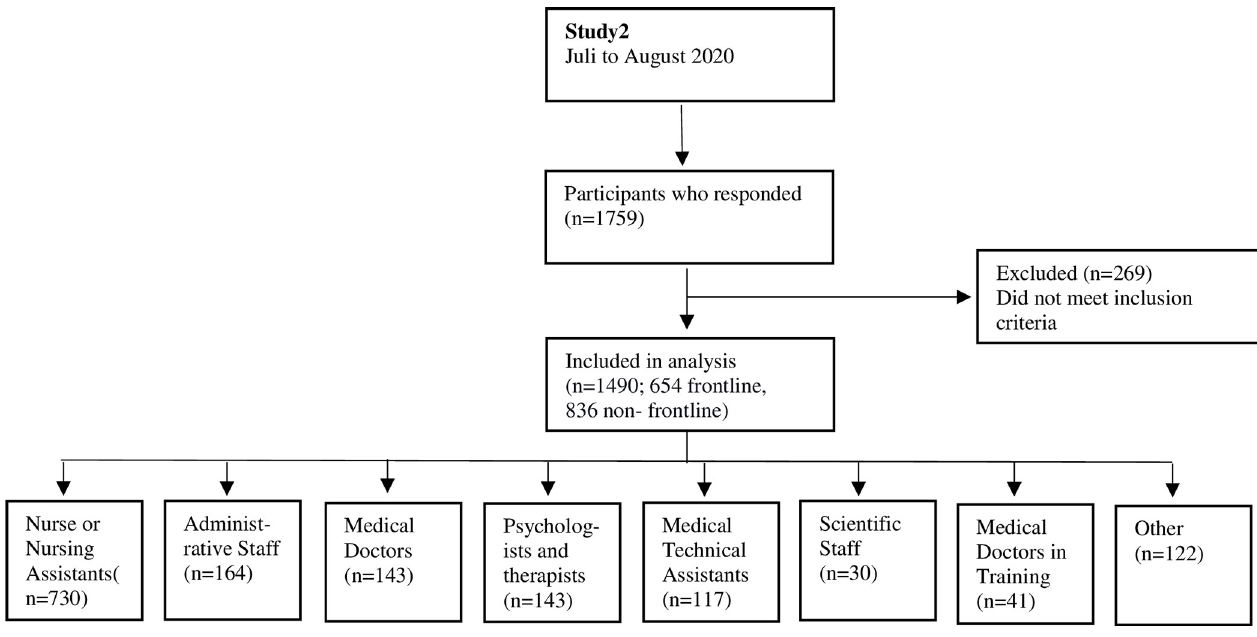
Fig 2. Flowchart of Study2 design and